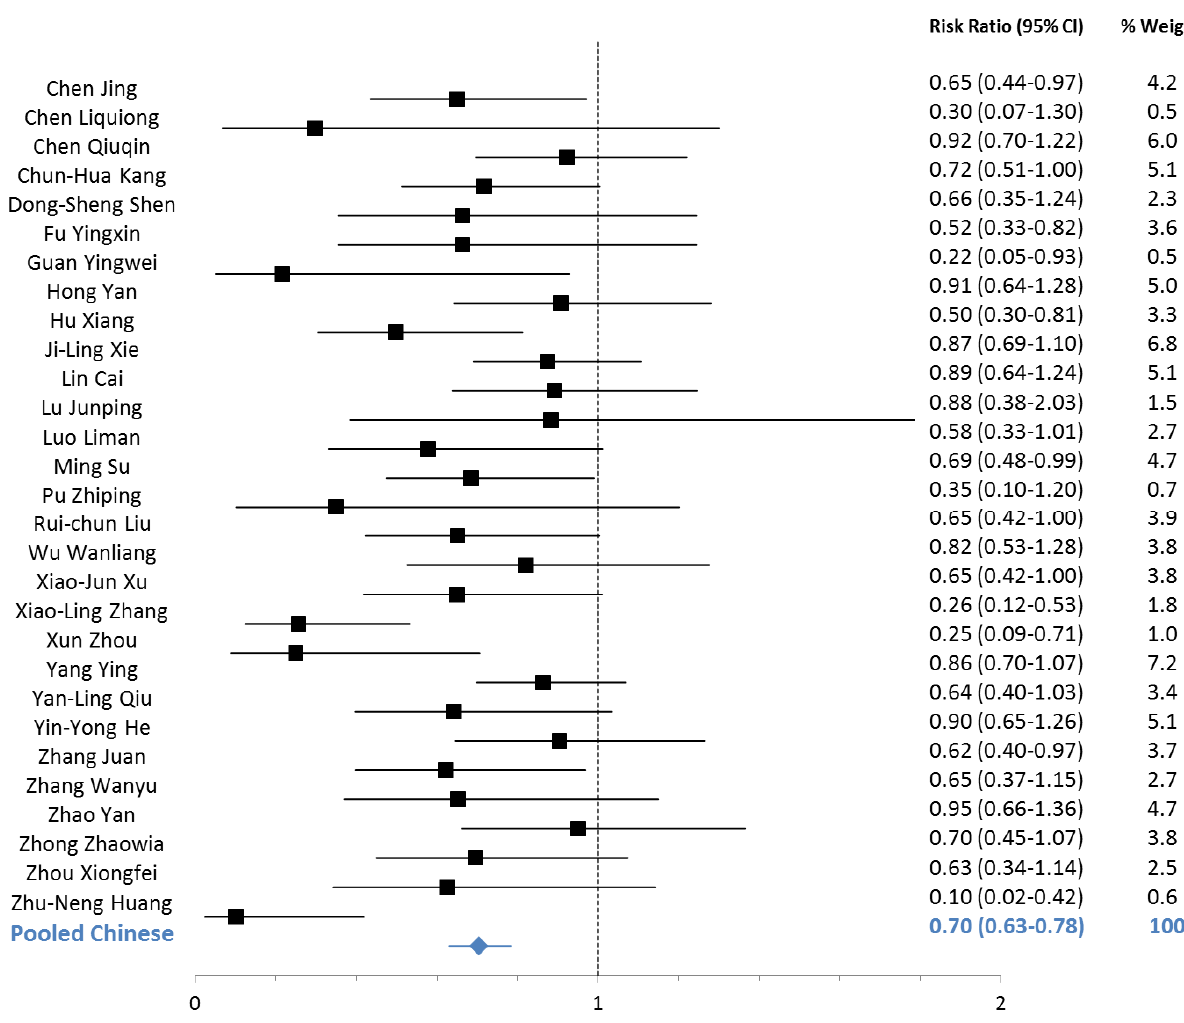
Figure 2. Forest plot for the effect of therapeutic zinc supplementation on Rotavirus diarrhea episodes >3